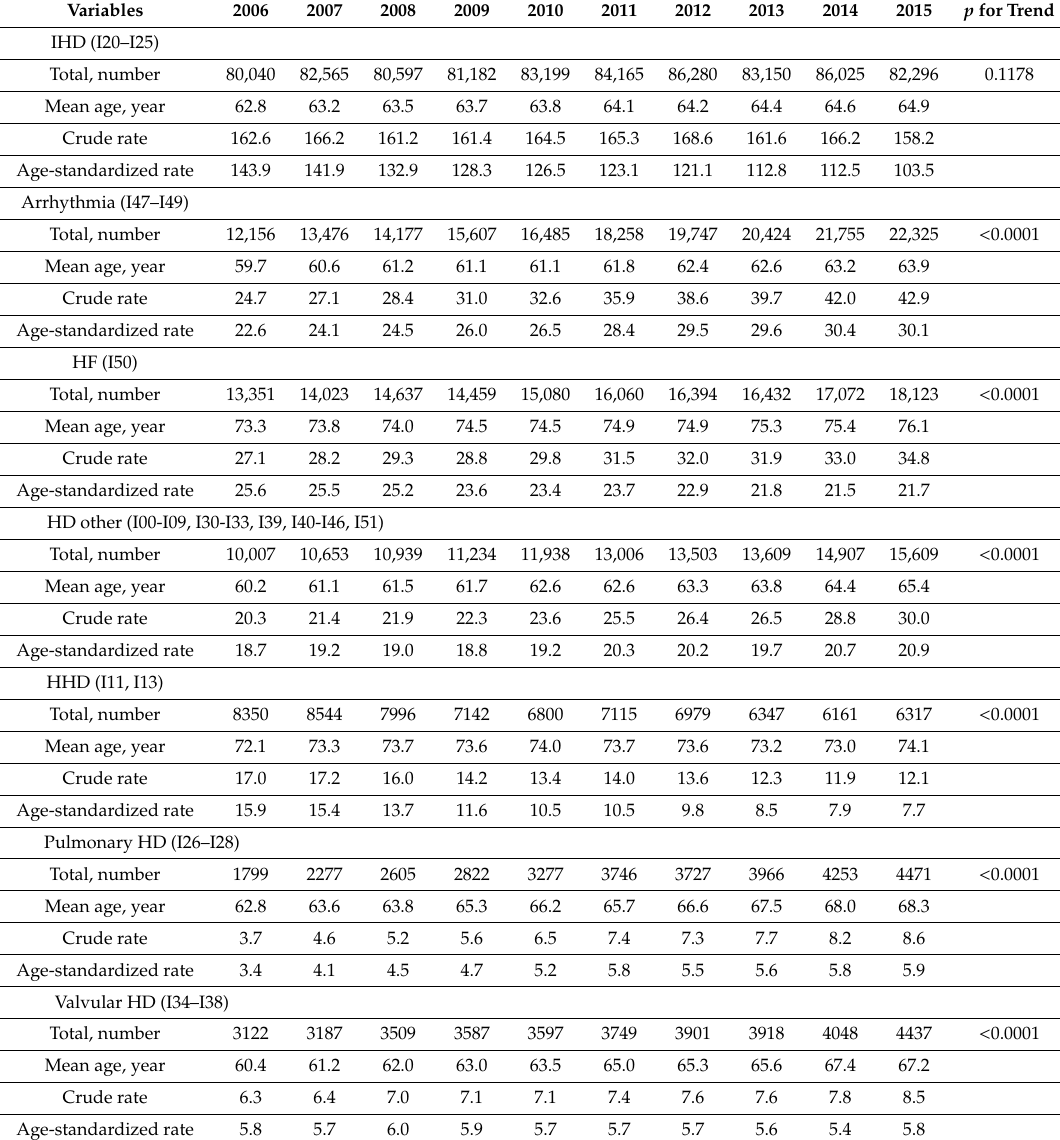
Table 2. Annual incident numbers and incidence rates of HD Subtypes in Korea,